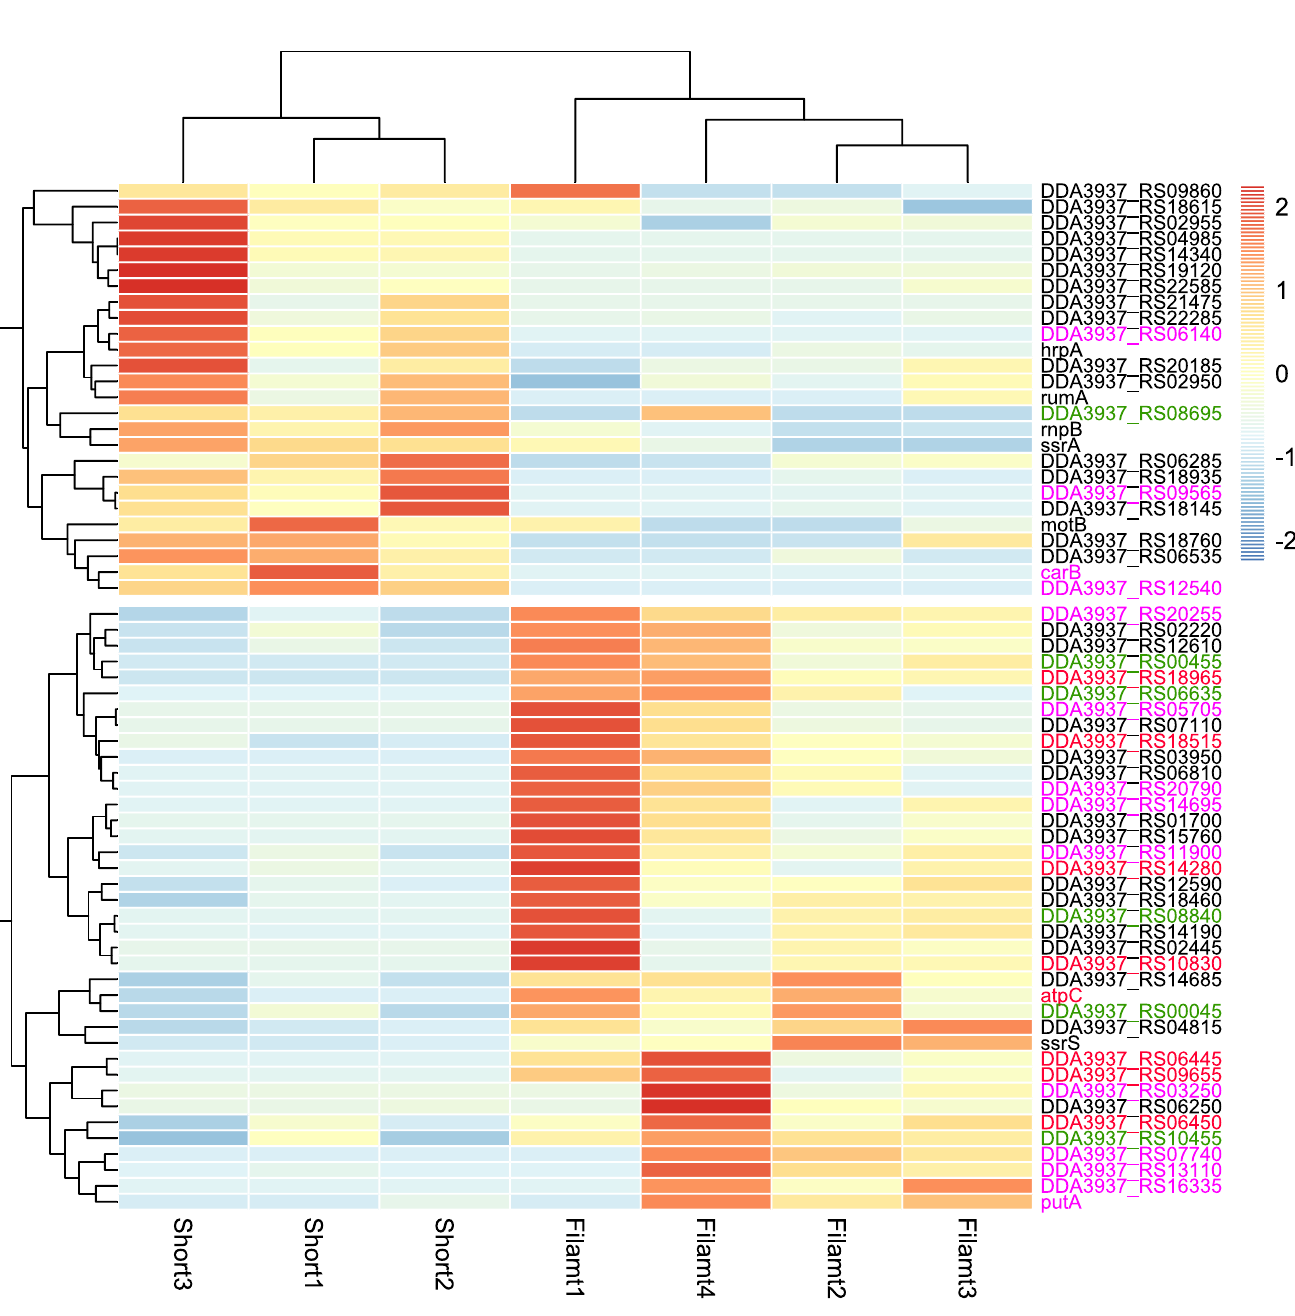
Fig 9. Genes differentially expressed in filamentous cells and short cells identified by RNA-seq. Relative mRNA abundance in each sample was indicated by color. Gene IDs were color-coded into the following categories: transportation (green); respiration (red); metabolism (magenta).